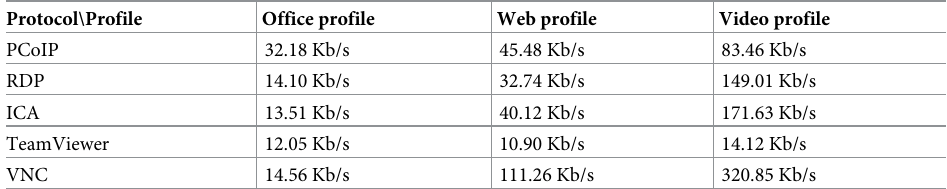
Table 4. Average upstream rate per remote desktop protocol.